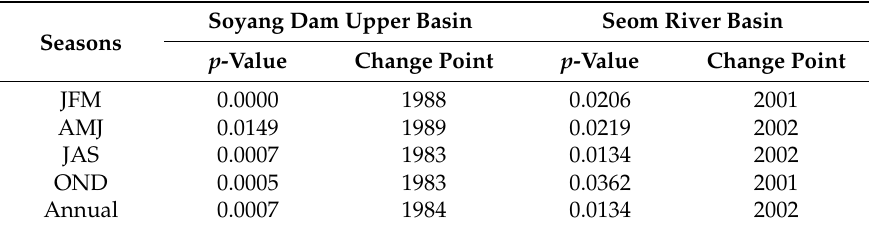
Table 3. Results of change point detection by Pettitt’s test under the 5% significance level.